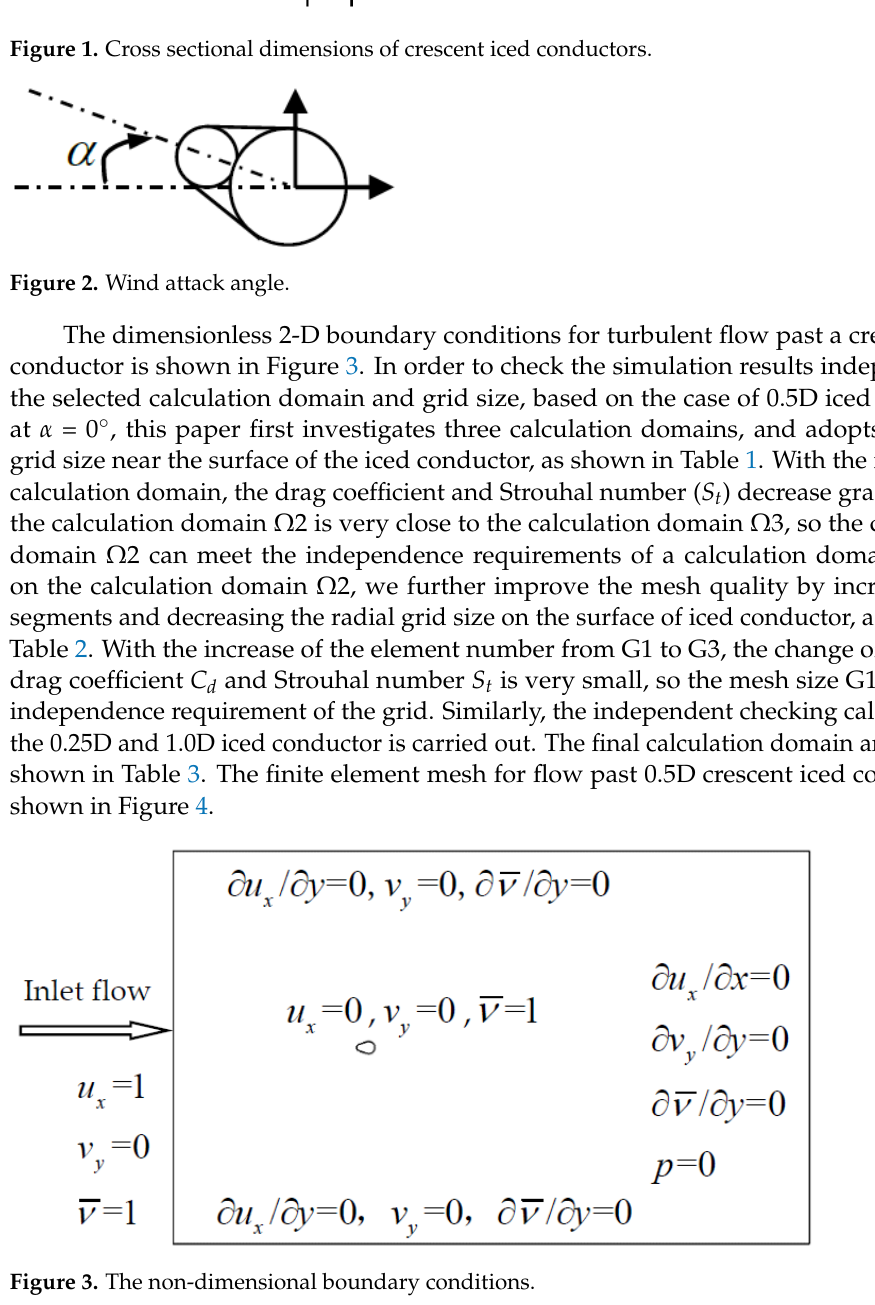
Figure 3. The non-dimensional boundary conditions. Table 1. Result comparisons of different computational domain.